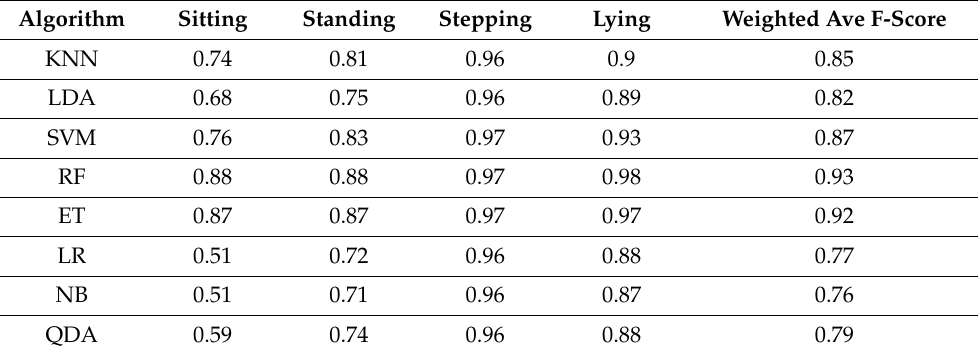
Table 2. Table of F-scores for each posture class and weighted average F-scores for each model with a 15 s window length.